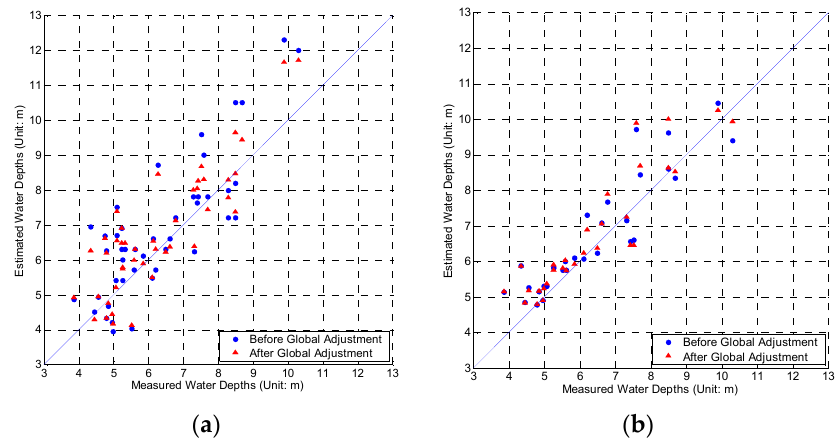
Figure 11. The comparisons between the estimated and measured water depths: ( a ) ZY-3; and ( b ) WV-3.